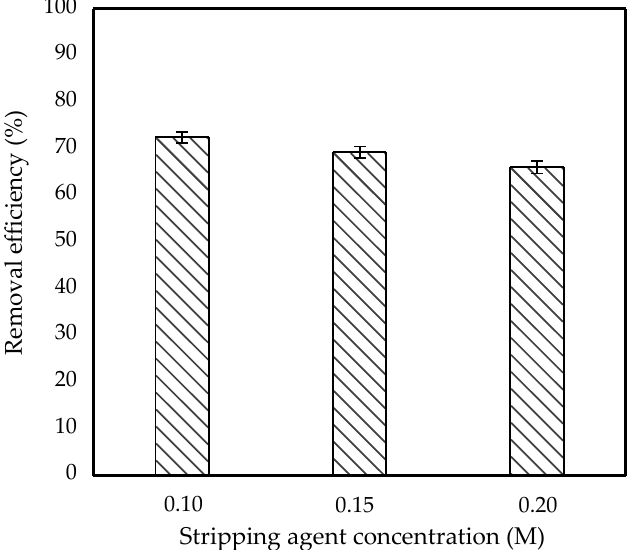
Figure 7. Effect of stripping agent concentration on removal efficiency of 10 ppm IBP. (Condition: [TOA] = 6 wt%; [Span 80] = 6 wt%; Emulsification time = 20 min; Stirring speed = 300 rpm; O/I = 3:1; Kerosene = 30 mL).